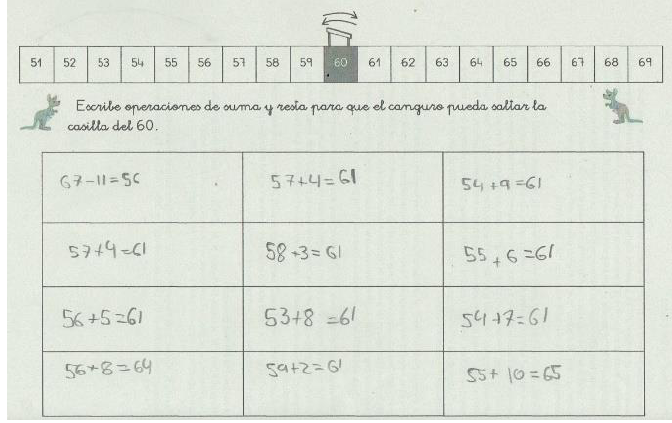
Figure 26. Kangaroo child activity 1: “Write additions and subtractions in such a way that the kangaroo overcomes number 60”.